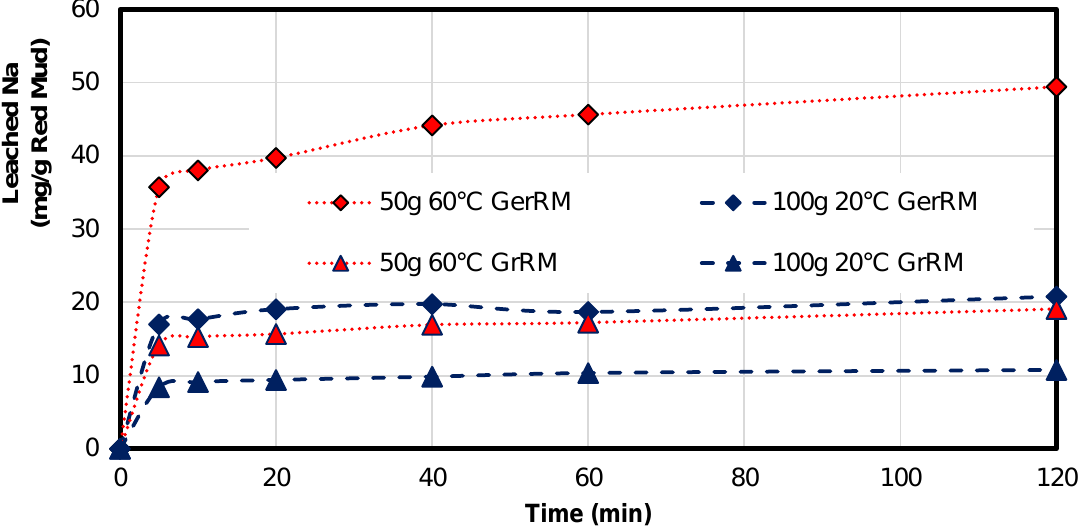
Figure A1. Kinetics of sodium adsorption for German and Greek red mud [mg / g].